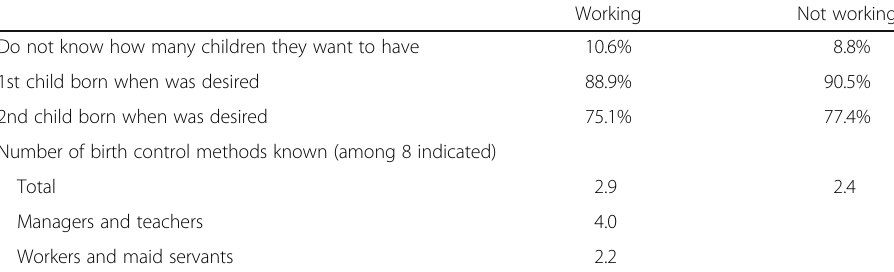
Table 8 Some characteristics of reproductive behavior, according to woman ’ s work. Three big cities in Italy, 1972